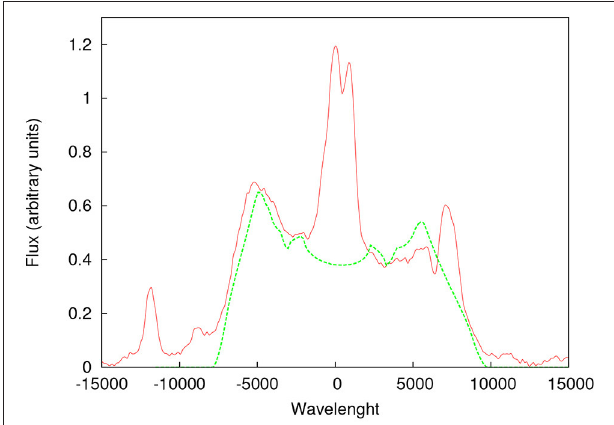
FIGURE 2 | An example of AD rings model matching the observed broad + H α emission line profiles. Here is presented the case of Arp